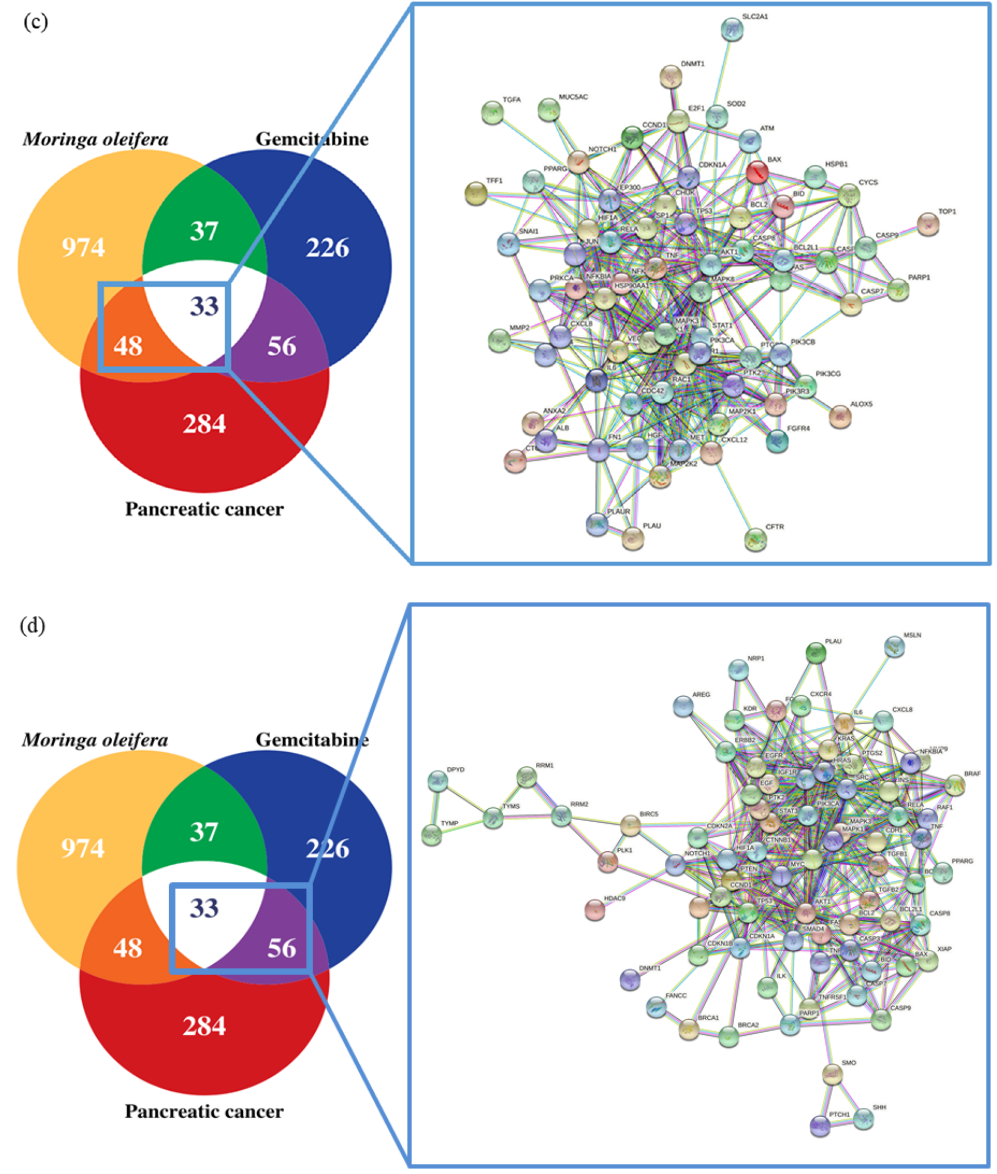
Figure 2. Targets of MO, GEM and their combinations against pancreatic cancer using STRING database. ( a ) Venn diagram and PPI network of MO + GEM intersection target genes against pancreatic cancer. ( b ) Venn diagram and PPI network of shared biotargets intersection against pancreatic cancer. ( c ) Venn diagram and PPI network of MO intersection target genes against pancreatic cancer. ( d ) Venn diagram and PPI network of GEM intersection target genes against pancreatic cancer.